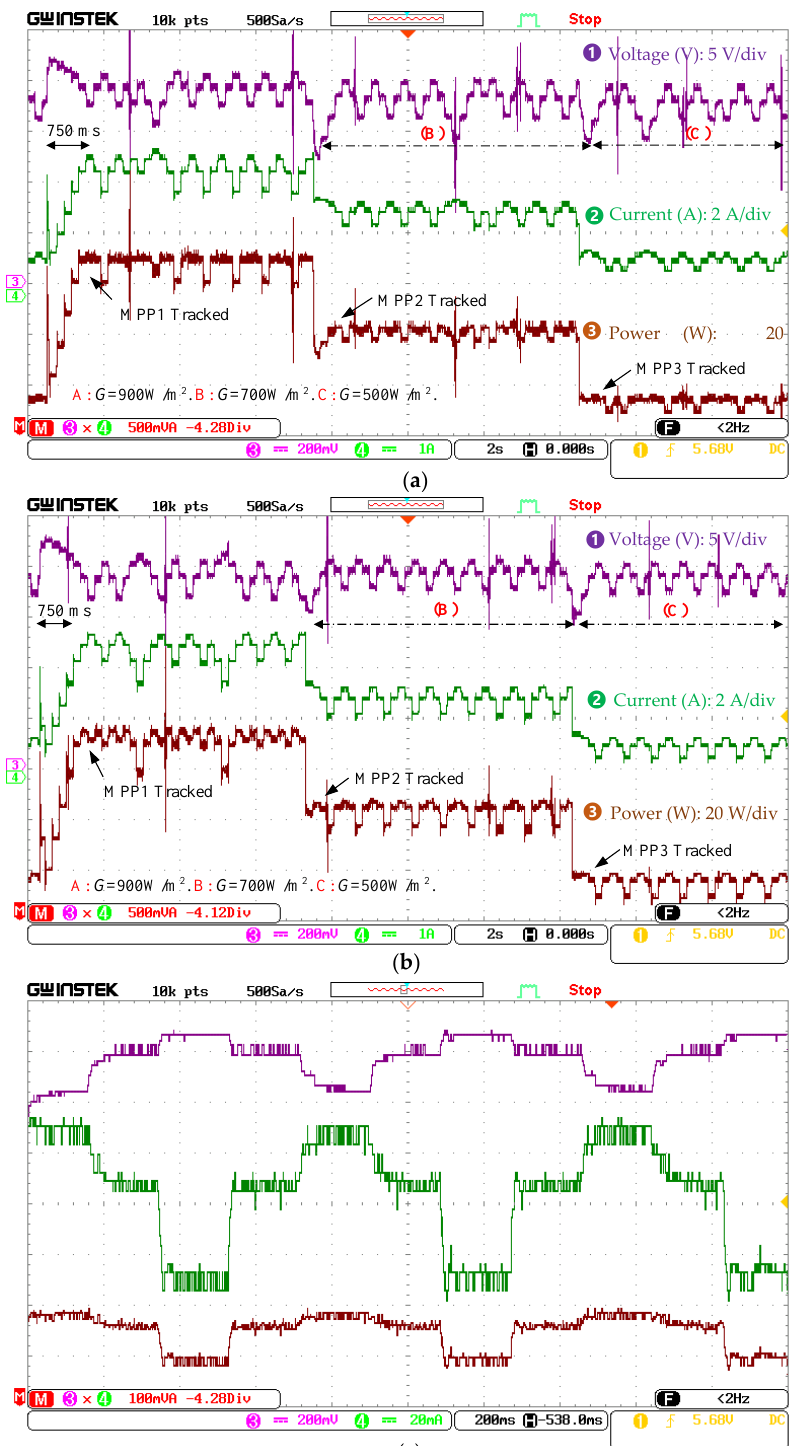
Figure 20. The tracking performance under irradiance changes: ( a ) experimental waveforms of CSL- MPPT, ( b ) experimental waveforms of the P&O-MPPT, and ( c ) the zoom portion of the three-level operation of the CSL-MPPT.